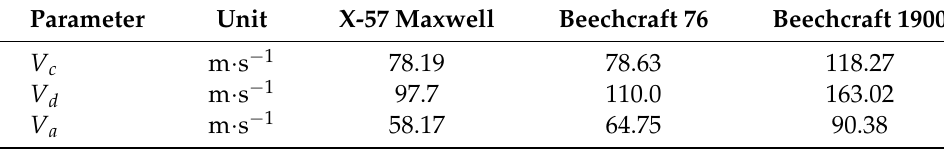
Table A4. Aircraft design airspeeds (EAS).